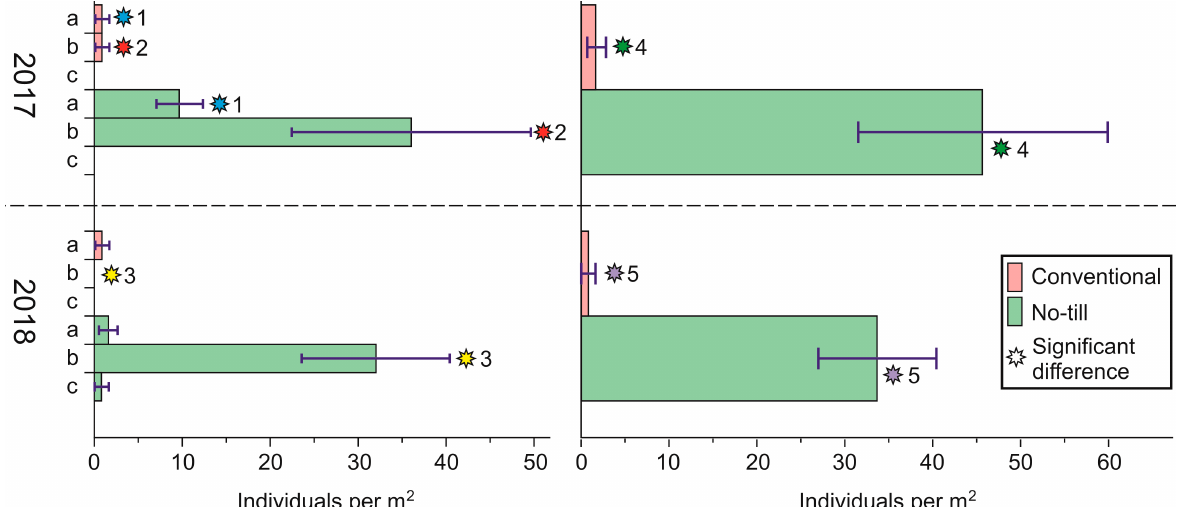
Figure 3. Mean earthworm abundance per square meter in CT and NT plots. Left: by species (a: Eisenia nordenskioldi (mature), b: Eisenia nordenskioldi (immature), c: Eisenia fetida (immature). Right: overall density of earthworms. Standard error is shown by whiskers. Stars of one color with same figures show the significant difference between certain parameters.